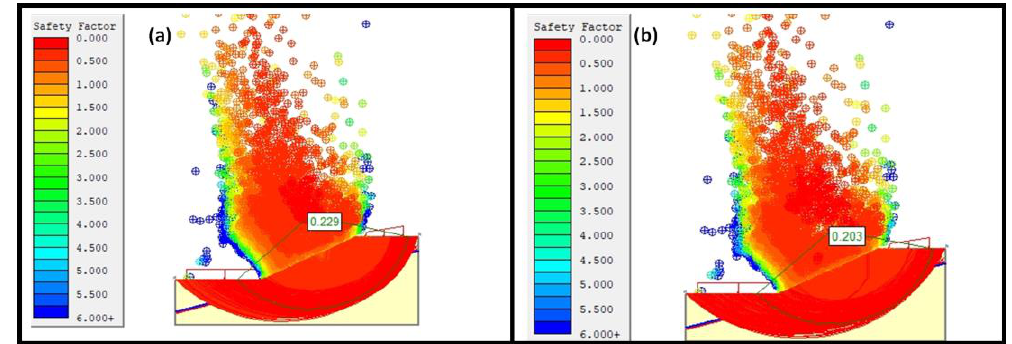
Figure 11. Safety factor simulated for rainy conditions in clay soil slope using ( a ) Bishop’s simplified method and ( b ) Janbu’s simplified method . The FoS simulated using the two methods suggested unstable slope, which could have been affected by the increase in water table volume.